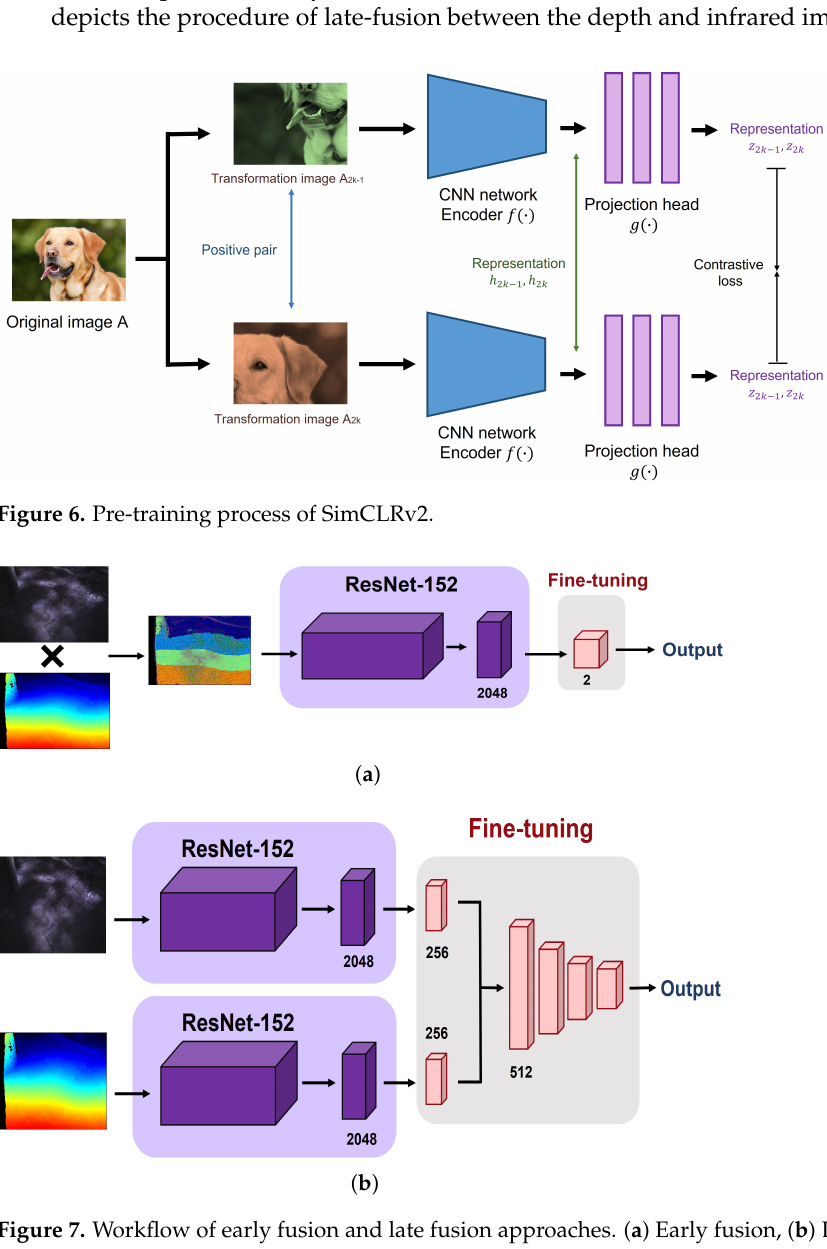
Figure 7. Workflow of early fusion and late fusion approaches. ( a ) Early fusion, ( b ) Late